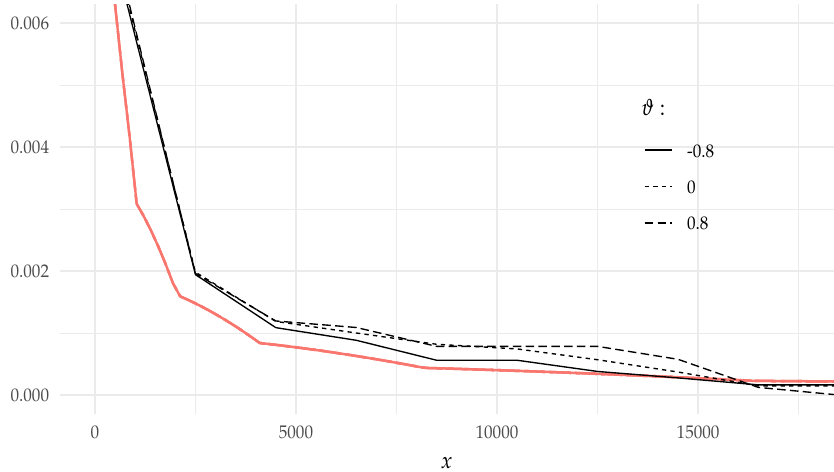
Figure 3. Simulated and asymptotic values for the truncated expectation of Example 5. Solid red line represents the exact asymptotic values of